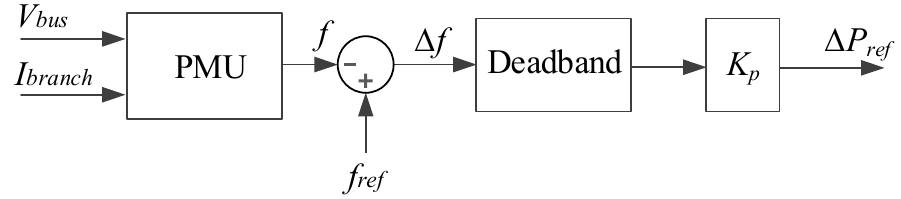
Figure 3. The droop-based FAPR controller block diagram.